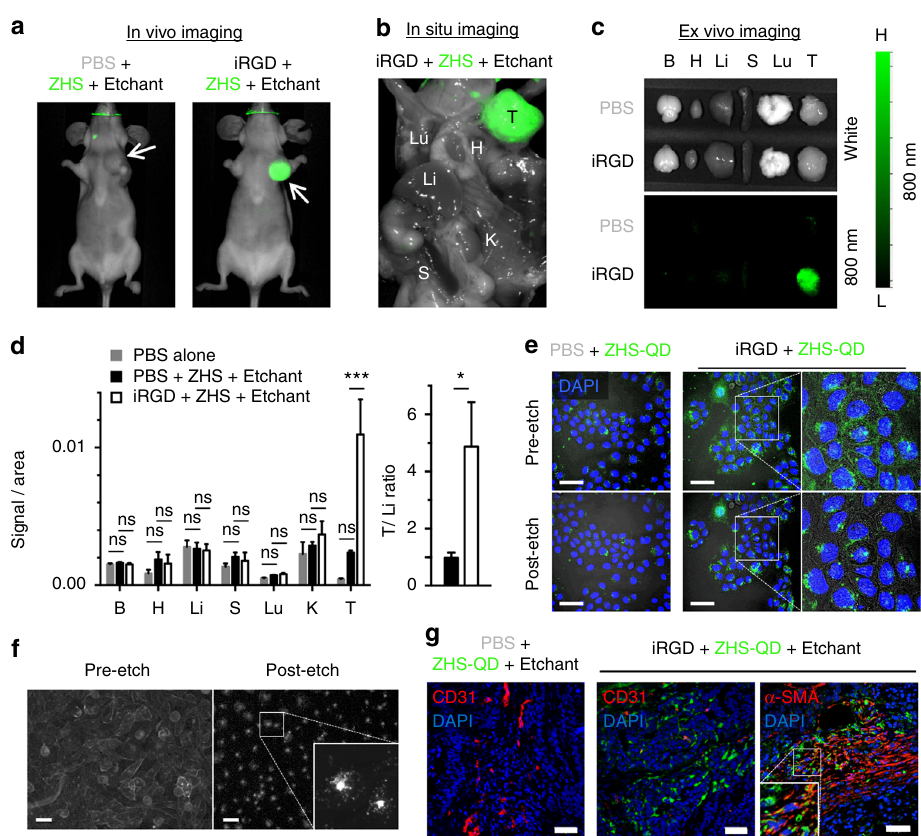
Fig. 4 Breast tumor-speci fi c imaging achieved by extravascular delivery of etchable ZHS-QDs. Mice bearing orthotopic MCF10CA1a human breast tumors received an intravenous injection of iRGD or PBS before an intravenous dose of ZHS-QDs. Ag-TS was given intraperitoneally. n = 4 per group. a The mice were anesthetized and imaged with a Li-Cor Pearl imager 40 min after etching. Arrows , tumors. b In situ NIR imaging of the mice after euthanasia and necropsy performed under deep anesthesia. c NIR images of collected tissues. d NIR signal per unit area in collected tissues ( left panel ) and T/Li ratio ( right panel ). B, brain; H, heart; Li, liver; S, spleen; Lu, lung; K, kidney; T, tumor. Statistics, two-way analysis of variance ( left panel ) or Student ’ s t -test ( right panel ); error bars , SEM; ns, not signi fi cant; * P < 0.05; *** P < 0.001. e Confocal micrographs of cultured MCF10CA1a cells treated with ZHS-QDs with or without free iRGD followed by etching with Ag-TS. Note that the QDs were internalized into the cells in the presence of iRGD, and that only the extracellular QDs were etched. Blue, Hoechst 33342; green, ZHS-QDs; scale bars , 50 μ m. Insets show a magni fi ed view of the boxed areas . f Epi fl